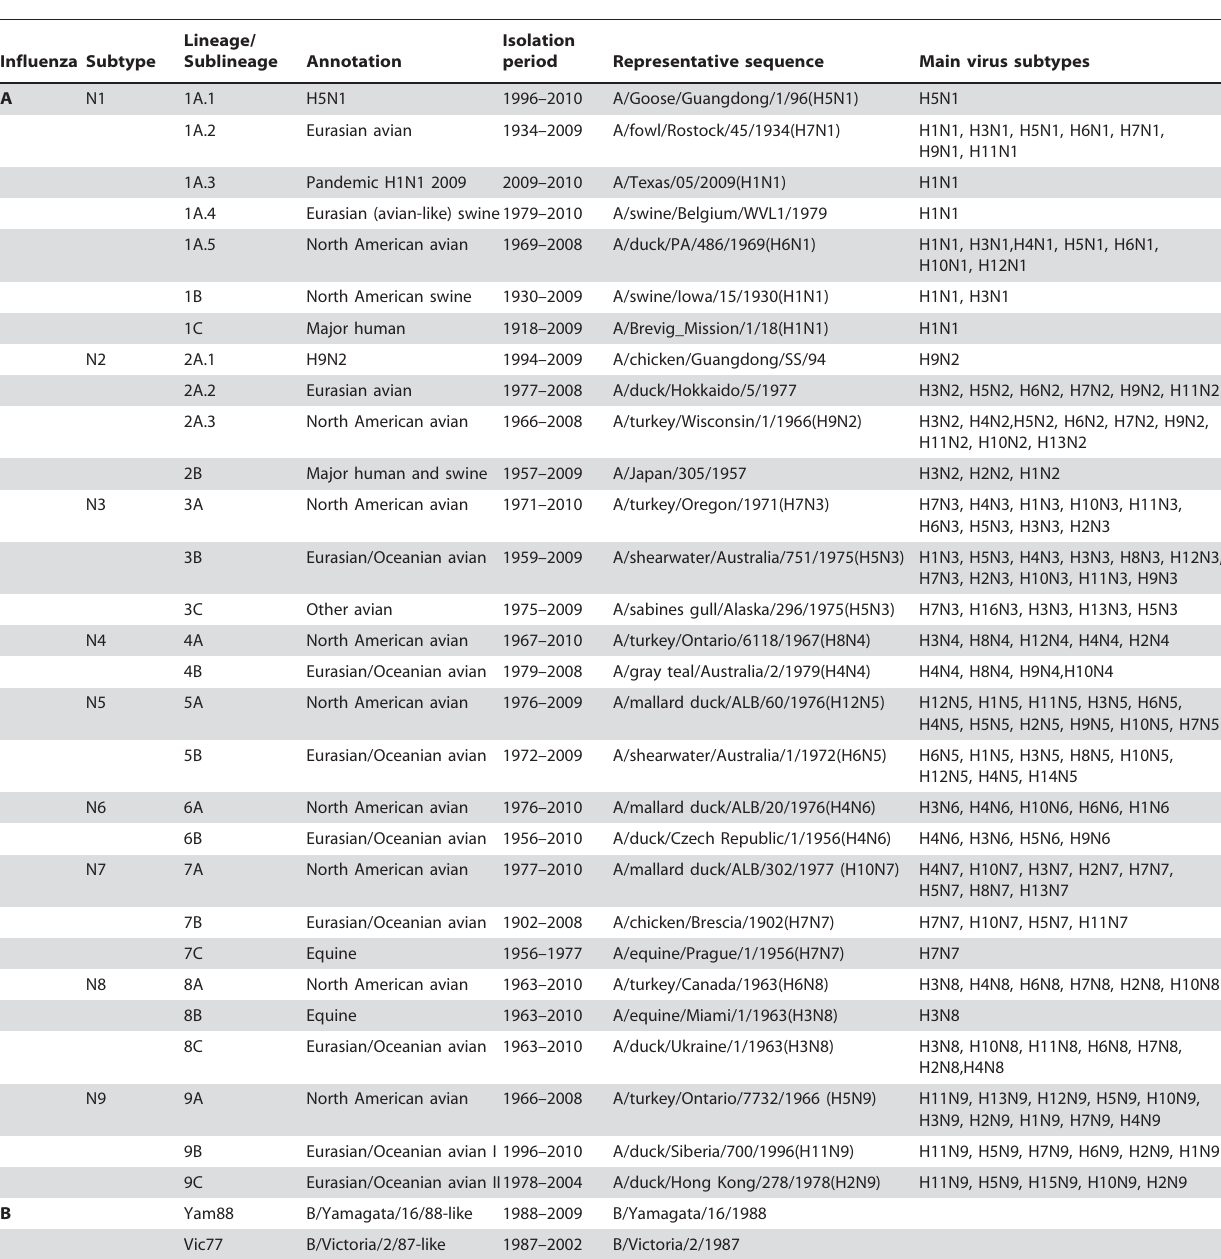
Table 1. The annotations, isolation periods, representative sequences and subtypes for the NA